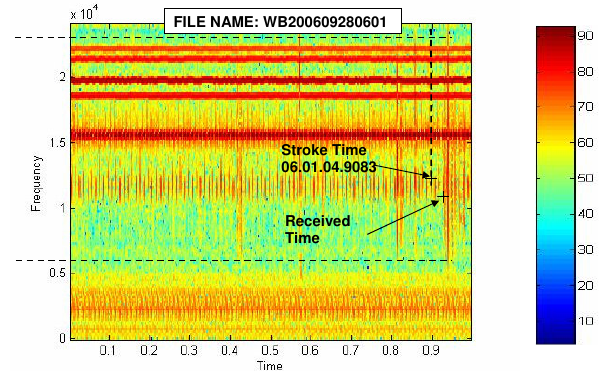
Table 2. Sample WWLLN data.